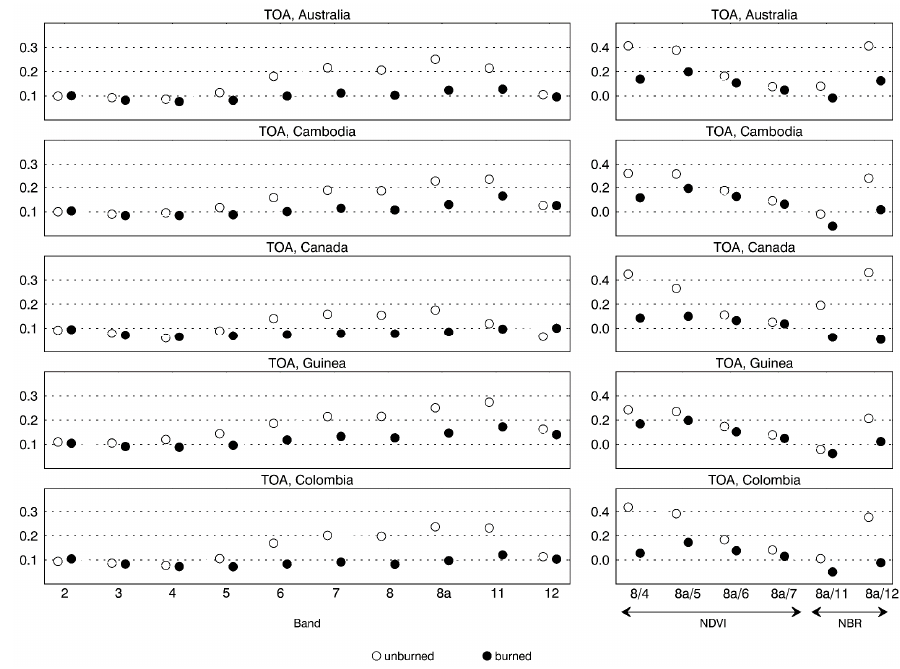
Figure 1. Mean unburned and burned MSI band (Table 2) and spectral index (Table 3) top of atmosphere (TOA) values.